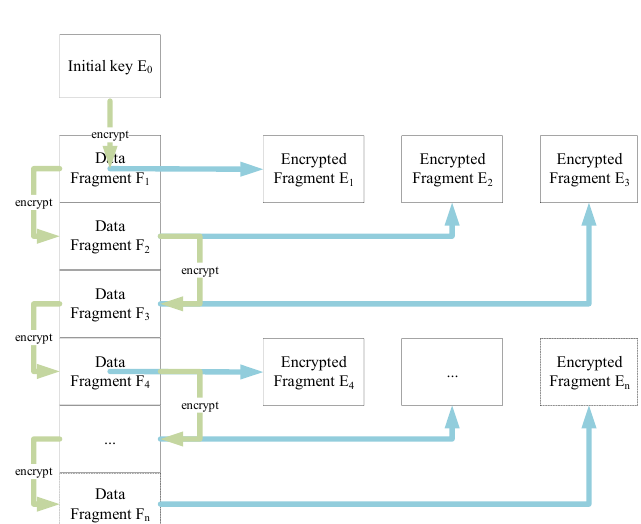
Figure 4. Encryption Process of Data